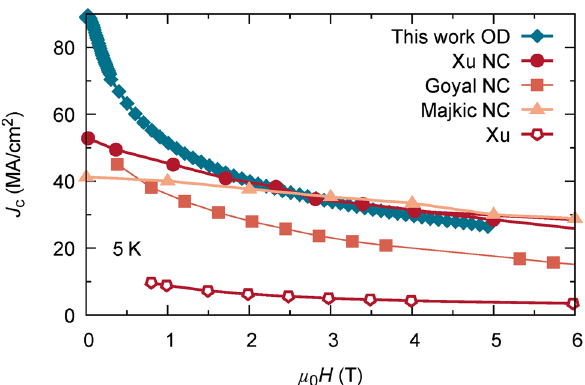
c ) at 5 K of some best performing YBCO films. Field dependence of reported high critical Figure 8. J c ( H (cid:31) current densities for several nanocomposite (NC) YBCO thin films in comparison with overdoped (OD) YBCO obtained in this work (PLD). Overdoped YBCO exhibits a remarkable self-field inductive J c , almost 60% higher than previous record films, compensating the fast decrease of J c ( H ) at low fields as typical for pristine YBCO films. From literature reproduced results cover the currently best-practice strategies of nanoengineering YBCO of coated conductors: 15% Zr doped (Gd,Y)BCO (Xu NC, MOCVD, at 4.2 K, reproduced under CC-BY) 42 , nanoscale defected REBCO with 4% BZO (Goyal NC, PLD, at 5 K, reproduced under CC-BY) 78 , REBCO with 15% Zr addition (Majkic NC, MOCVD, at 4.2 K, raw data was kindly provided by the author) 79 . Additionally we show a pristine YBCO film (Xu, MOCDV, at 4.2 K, reproduced with permission from AIP publishing) as reported in 72